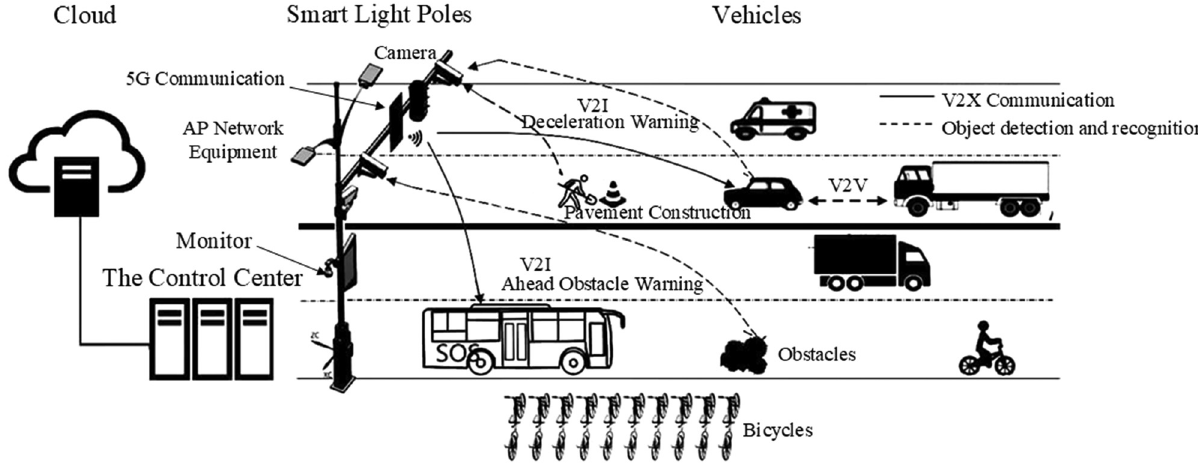
Figure 2: Application of smart light pole in